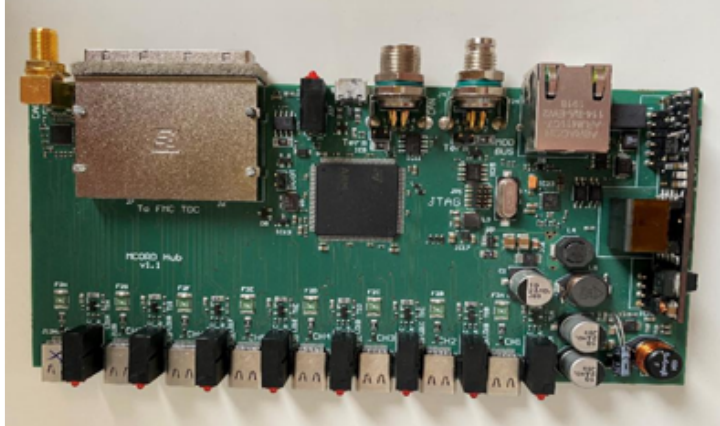
Figure 7. MCORD HUB electronics board.